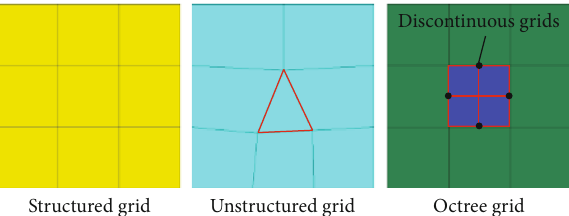
Figure 6: Typical grid types in FLAC 3D .